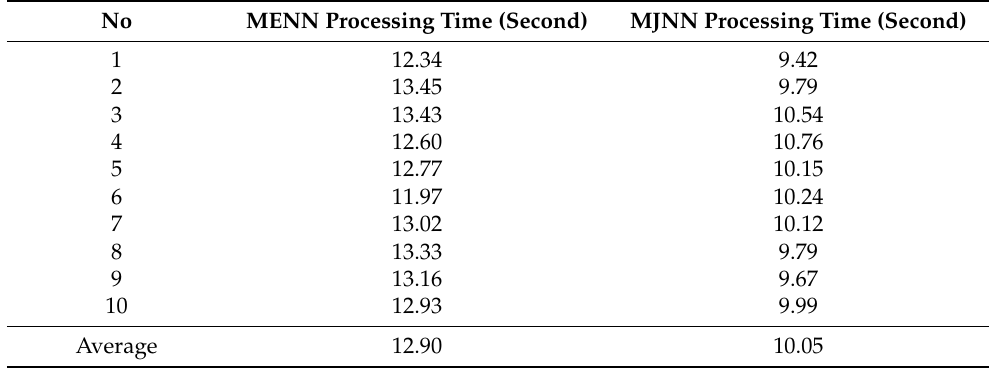
Table 1. Processing time